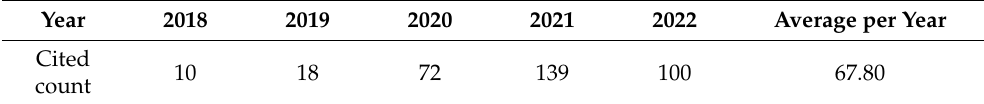
Table 5. Citations of the last 4 years (data from 2018 to